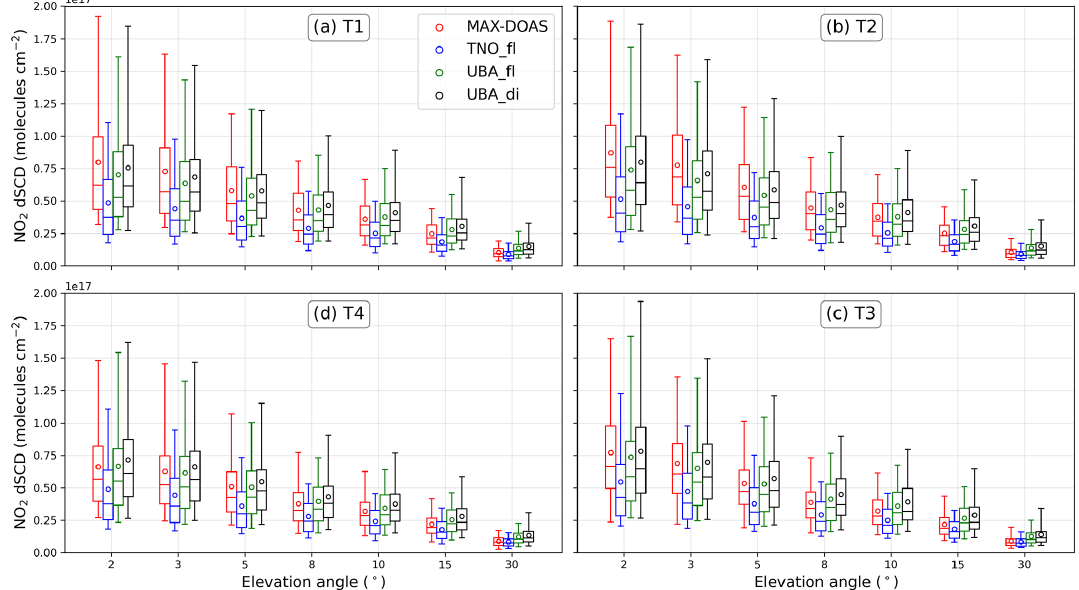
Figure 10. Box and whiskers plots for the different telescopes (a–d) showing the distribution of measured and simulated dSCDs for the three different model set-ups (depicted in different colours) for various elevation angles (2, 3, 5, 8, 10, 15, and 30 ◦